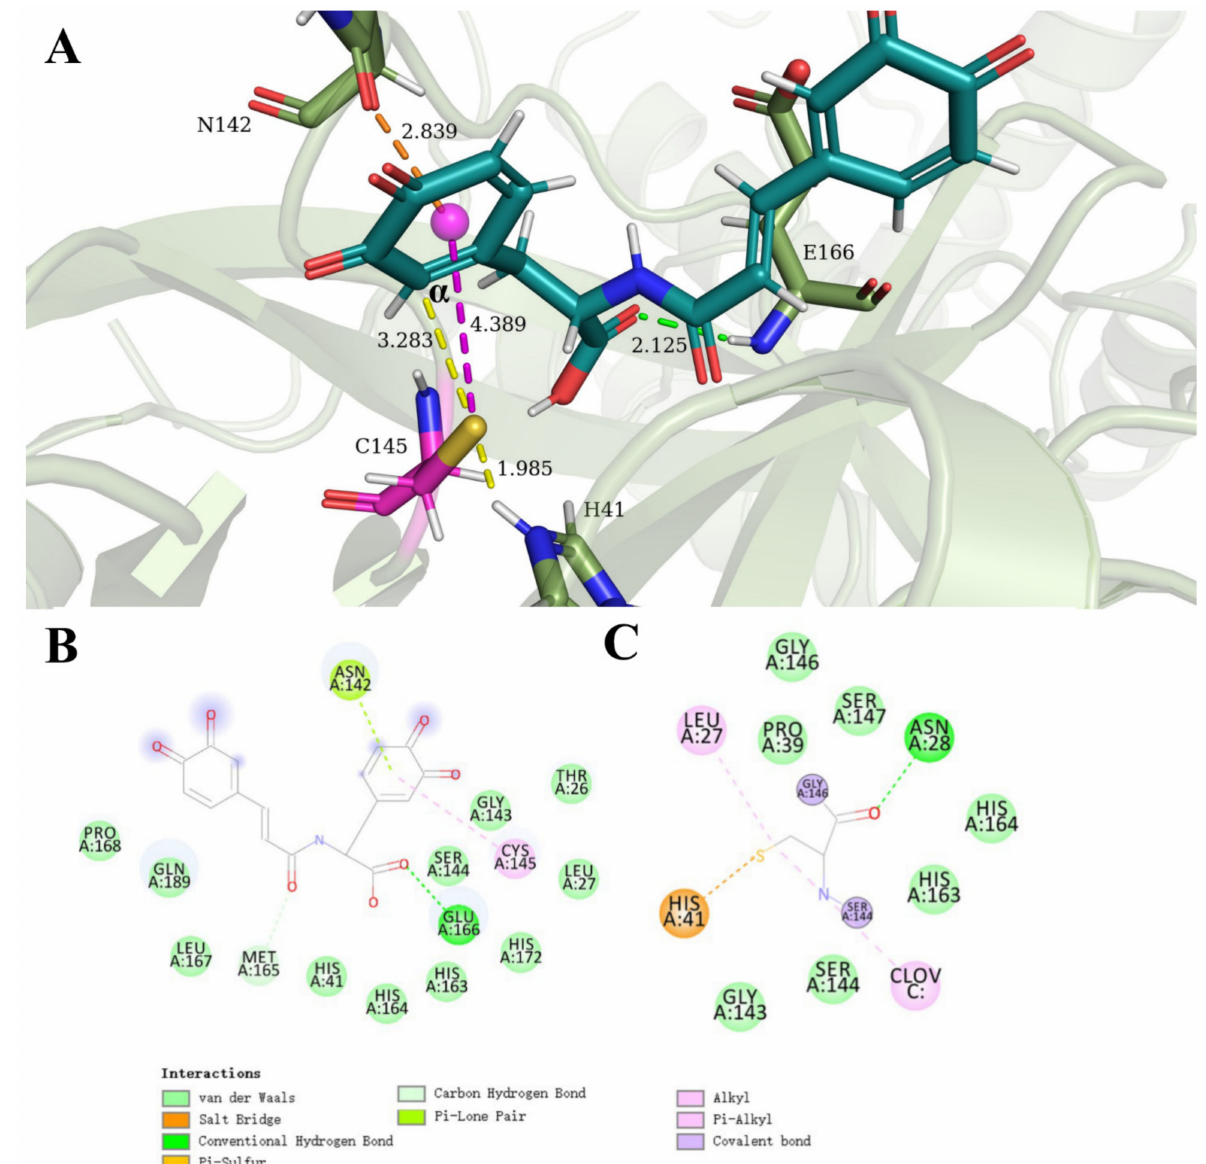
Figure 8. ( A ) Resulting conformation of the standard dynamics cascade of pose 3. Starting with the native thiolate form, the C145 formed covalent bonds via conjugate addition mechanism shown by Scheme 3(A2). The positively charged H41 residue in proximity stabilized the thiolate ion. N142 residue has a lone pair in the terminal carbonyl oxygen which interacts with the ortho-quinone π system providing extra stabilization forces (labeled in orange dashes). Yellow dash lines are two interatomic distances with C145: One is S(C145) to the α carbon adjacent to the carbonyl carbon (top) and the other is S(C145) to H(H41) (bottom); green dash lines represent hydrogen bonds; the magenta line indicates the distance between C145 and the centroid of the catechol ring. ( B ) Two-dimensional diagram displaying non-covalent interactions between zwitterionic M pro and clovamide analogue C molecule docking pose 3 after standard dynamics cascade; ( C ) 2D display of interactions involved in C145 residue. The pink bubble labeled “CLOV C:” represents the clovamide analogue inhibitor